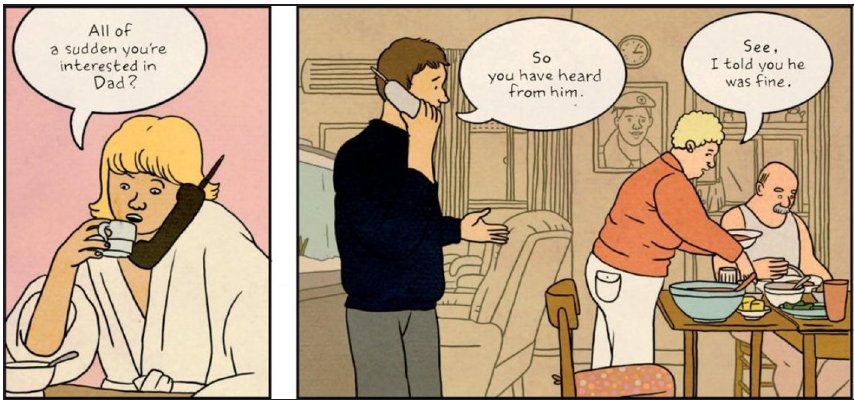
Figure 1: Potential Death and Normalcy in Exit Wounds by Rutu Modan, 2007: 21. © 2007 Drawn & Quarterly – Rutu